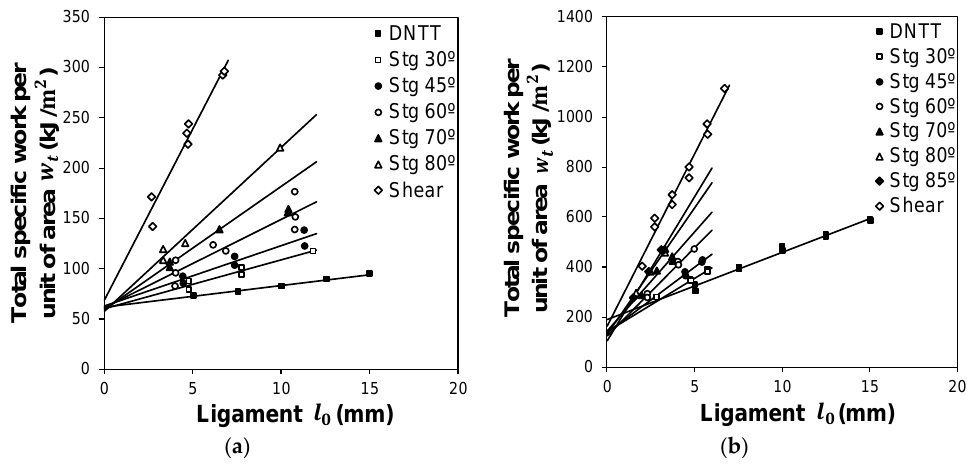
Figure 11. Experimental evolutions of the total specific work per unit of area 𝑤 𝑇 with the ligament length 𝑙 0 for the DNTT, staggered DNTT with various stagger angles 𝛼 and shear test specimens, in case of ( a ) aluminium AA1050-H111 and ( b ) copper. Table 6. Fracture toughness of the aluminium AA1050-H111 and copper sheets with 1 mm thickness obtained from different tests.